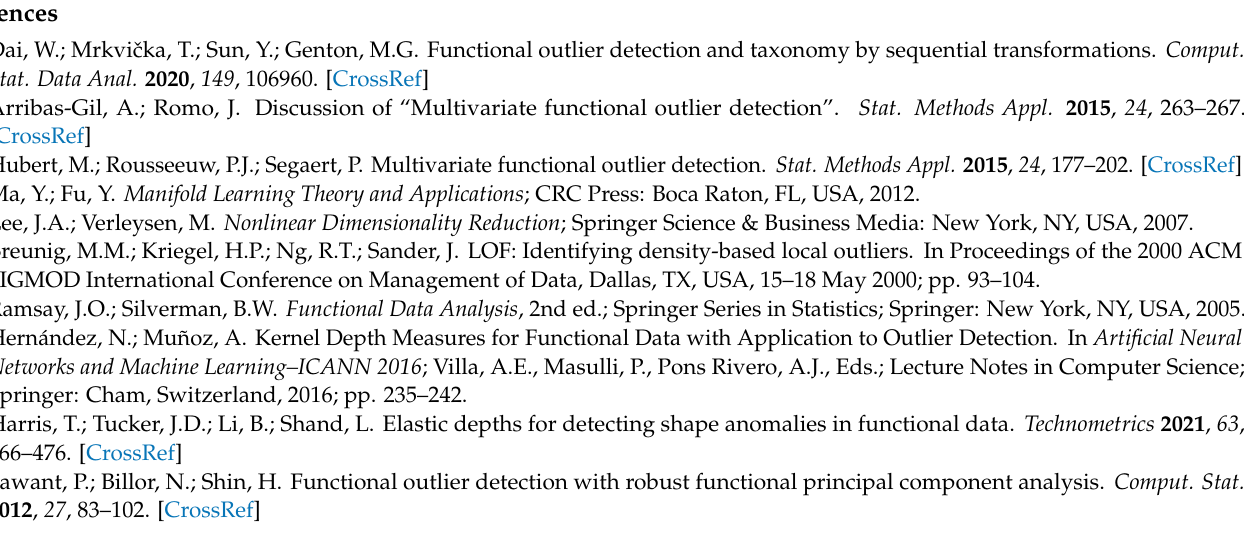
Figure A17. ArrowHead data. Top: the complete dataset. Middle and bottom: two example outlier datasets. Inliers from class “Avonlea” in black; outliers sampled from classes "Clovis” and “Mix” in red. Outlier ratio